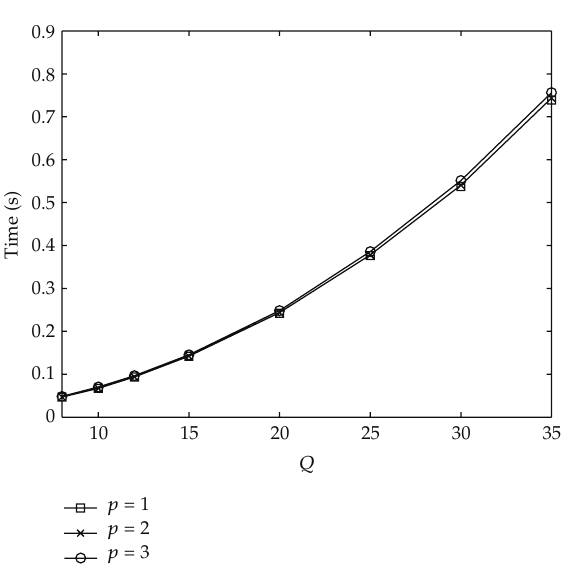
Figure 4: Computation cost when solving p performance parameters